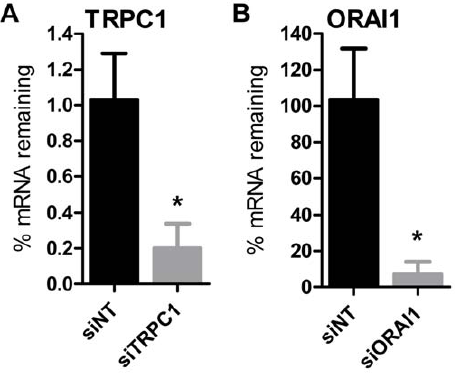
Figure 5. siRNA-mediated silencing of ORAI1 and TRPC1 in MDA-MB-468 breast cancer cells. A ) Quantitation of TRPC1 mRNA expression 48 h after treatment with TRPC1 siRNA (siTRPC1) relative to the non-targeting siRNA control (siNT). B ) Assessment of ORAI1 expression 48 h post transfection with ORAI1 siRNA (siORAI1). Values show mean 6 S.D. for six wells from three independent experiments; * P , 0.05 (unpaired t-test).